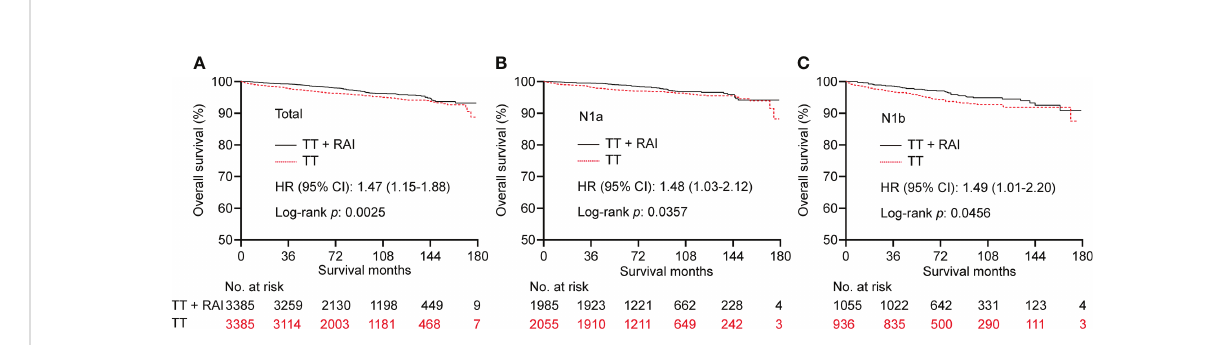
FIGURE 3 Kaplan – Meier curves of OS in PTC patients who underwent TT vs. TT+RAI after PSM in total patients (A) , N1a patients (B) , and N1b patients (C) . OS, overall survival; PTC, papillary thyroid carcinoma; TT, total thyroidectomy; RAI, radioactive iodine; PSM, propensity score matching.